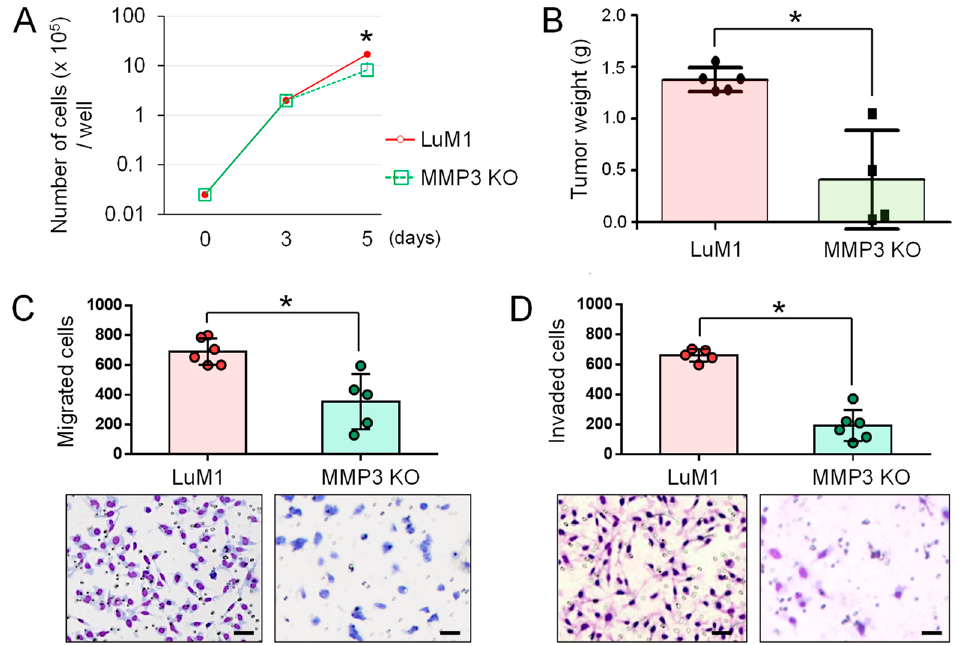
Figure 4. The knockout of MMP3 suppressed tumor progression. ( A ) Growth curves of LuM1 and Figure 4. MMP3-KO cells. n = 3. * p < 0.05. ( B ) Subcutaneous tumor weights of LuM1 vs. MMP3-KO cells in the allograft model. Tumor weights were measured on day 21 after transplantation. LuM1 group, n = 6; MMP3 KO group, n = 5. * p < 0.05. ( C ) Column scatterplot of in vitro migration activities altered by MMP3 knockout. Top, the number of migrated cells. n = 5, * p < 0.05. Bottom, representative images of migrated cells stained with Di ff -Quick. Scale bars, 50 µ m. ( D ) Column scatterplot of in vitro invasion activities. Top, the number of invaded cells. n = 5, * p < 0.05. Bottom, representative images of invaded cells stained with Di ff -Quick. Scale bars, 50 µ m. The experiments were repeated twice in Figure 4A,B and thrice in Figure